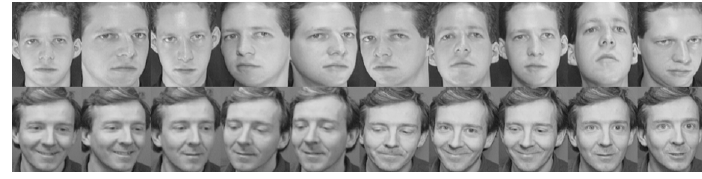
Figure 2. Example images from two subjects of the